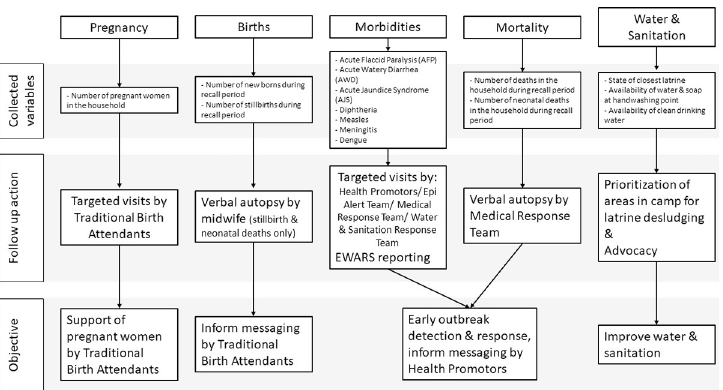
Fig 2. Use of CBS data to guide targeted programmatic interventions by MSF in Cox’s Bazar, Bangladesh, week 20–44,